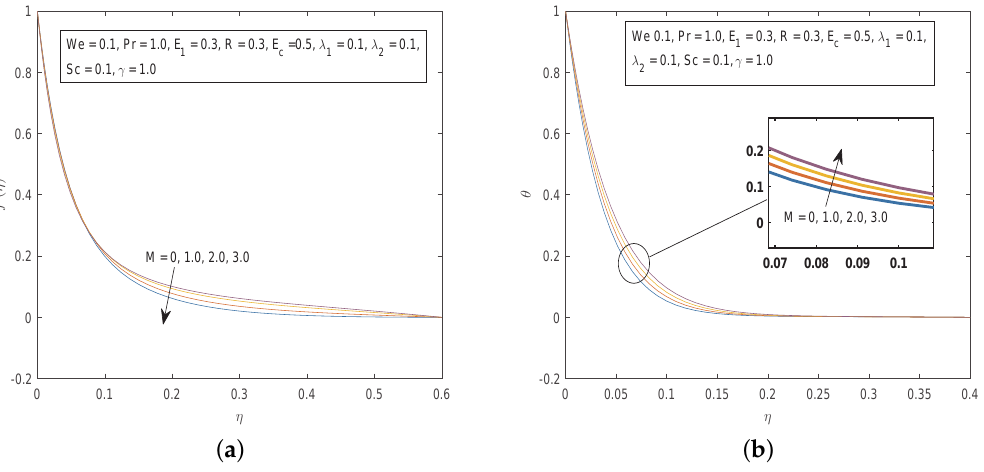
Figure 6. ( a ) Effects of M on f (cid:48) ( η ) and ( b ) Effects of M on θ